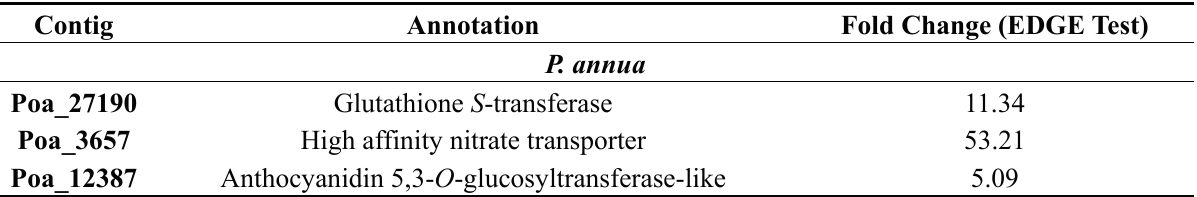
Table 1. Genes that were up-regulated under NaHCO 3 treatment (fold change > 2, FDR-corrected p -value < 0.05). The annotations were assigned by BDA (Blast2GO Descriptor Annotator), showing the words most frequently counted of all blast hit descriptions